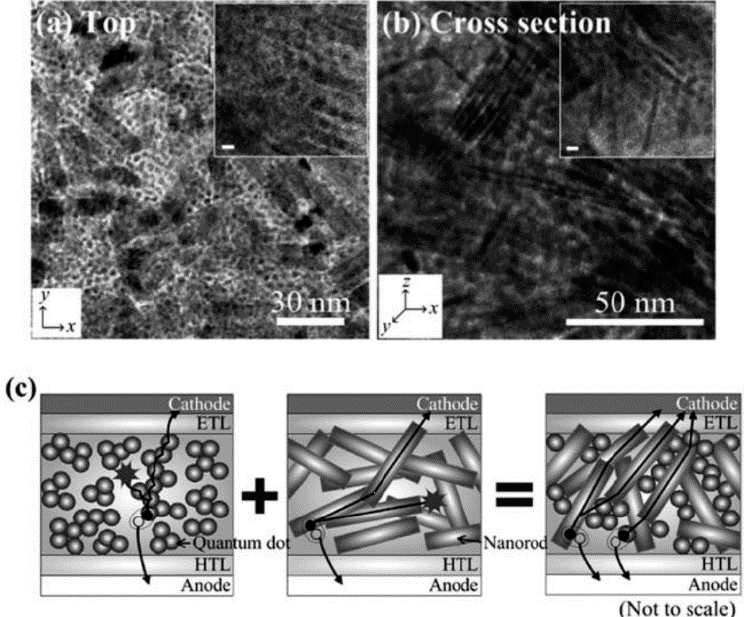
Figure 17. TEM images of the hybrid blend with QDs and NRs (0.3:0.7 wt/wt) in the PSBTBT matrix: ( a ) top and ( b ) cross-sectional views. The scale bars in the insets are 5 nm. Continuous interfacial contacts by both QDs and NRs are clearly shown in both horizontal and perpendicular directions of the film. ( c ) Cross-sectional schematic diagram of the three differently composed devices to explain the superiority of the hetero-structured blends. Reprinted with permission from Ref. [107]. Copyright Royal Society of Chemistry 2013.